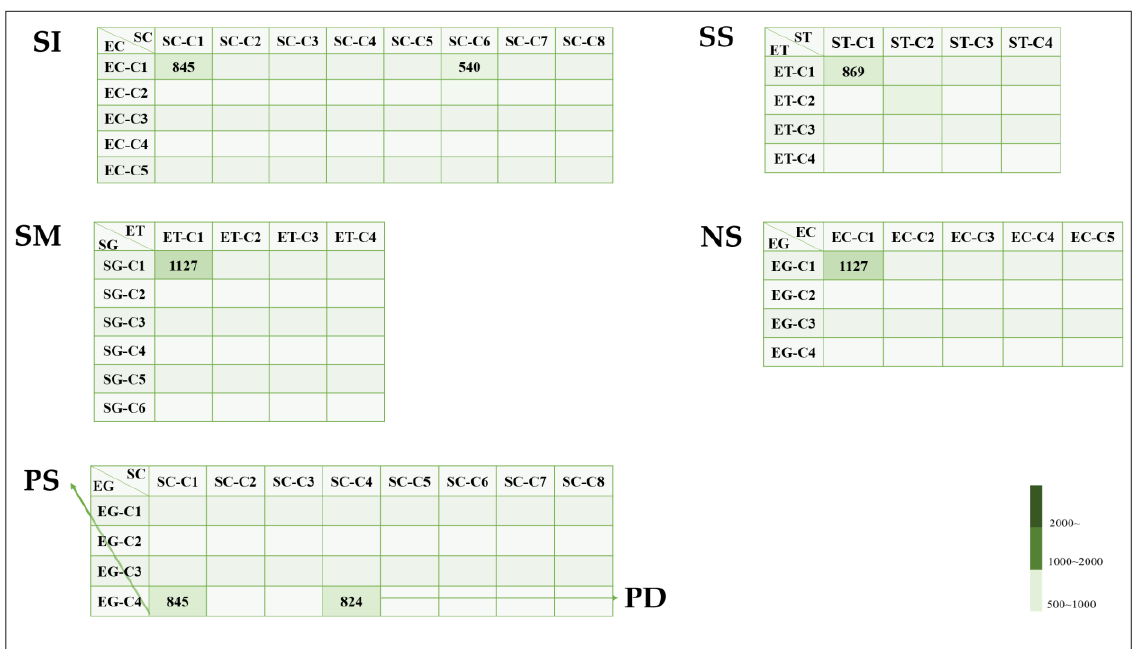
Figure 6. Detailed information on the proposed clustering. Table 1. Proposed picking grouping.